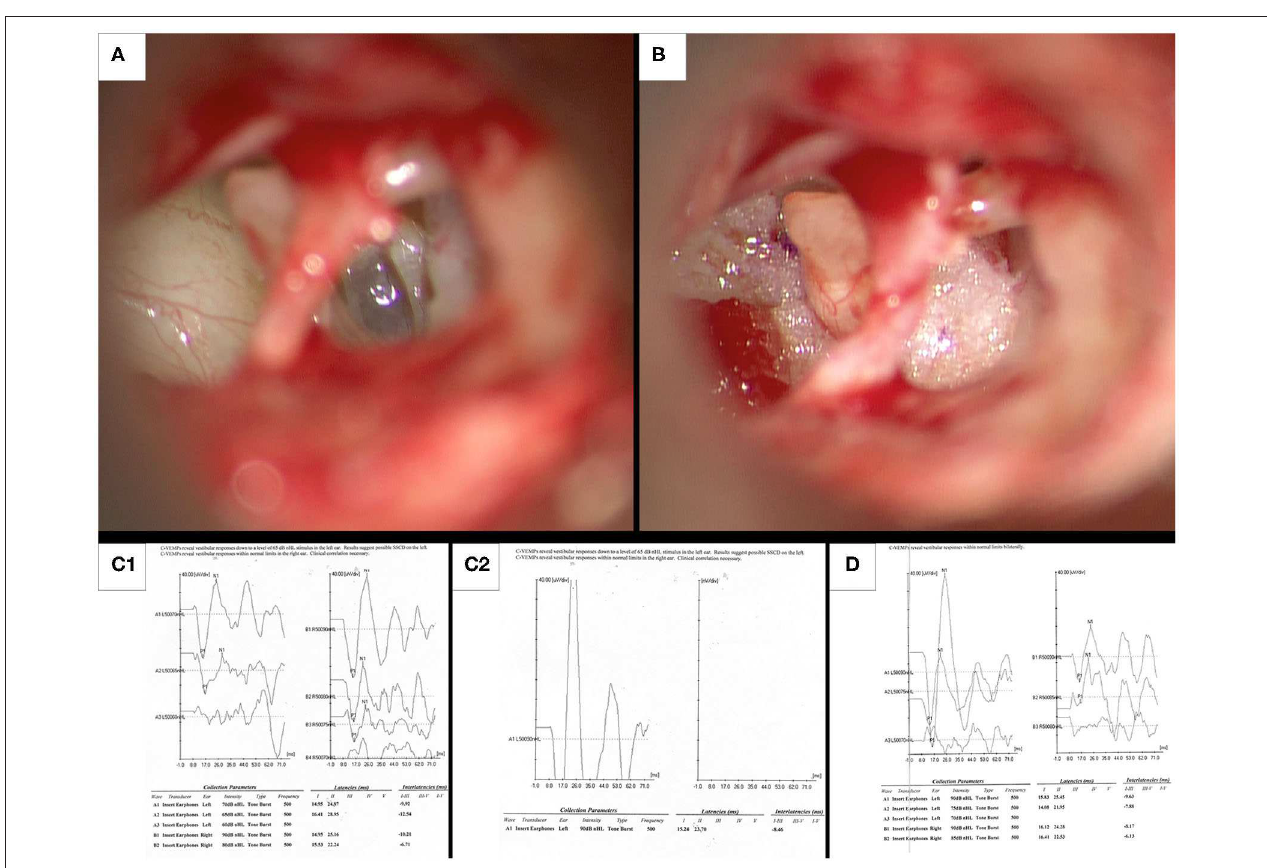
FIGURE 2 | Intraoperative photographs and preoperative and post-operative cVEMP responses in illustrative case 3. (A) Intraoperative appearance of a membranous translucent left stapes footplate. (B) Fat grafts obtained from the lobule are placed under the arch of the stapes and anterior and posterior to the crurae. (C1,C2) Preoperative cVEMPs on the left ear with increased amplitude and decreased threshold down to 65 dB nHL, along with normal cVEMPs in the right ear. (D) After auditory thresholds had normalized at 8 weeks following surgery, post-operative cVEMPs shows normalization of thresholds and amplitude on the left side. This suggests that surgery resulted in objective improvement in